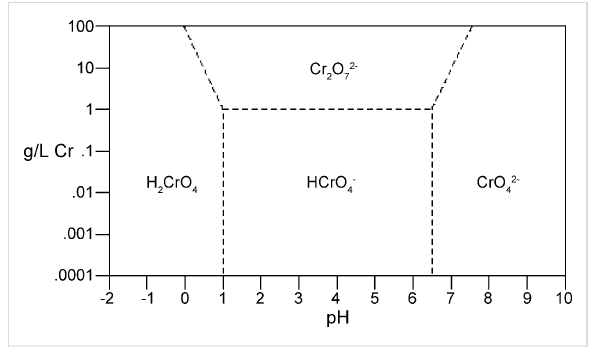
Figure 1: Speciation diagram of Cr(VI). Reprinted from [6], copyright 2016 Thermo Fisher Scientific Inc.